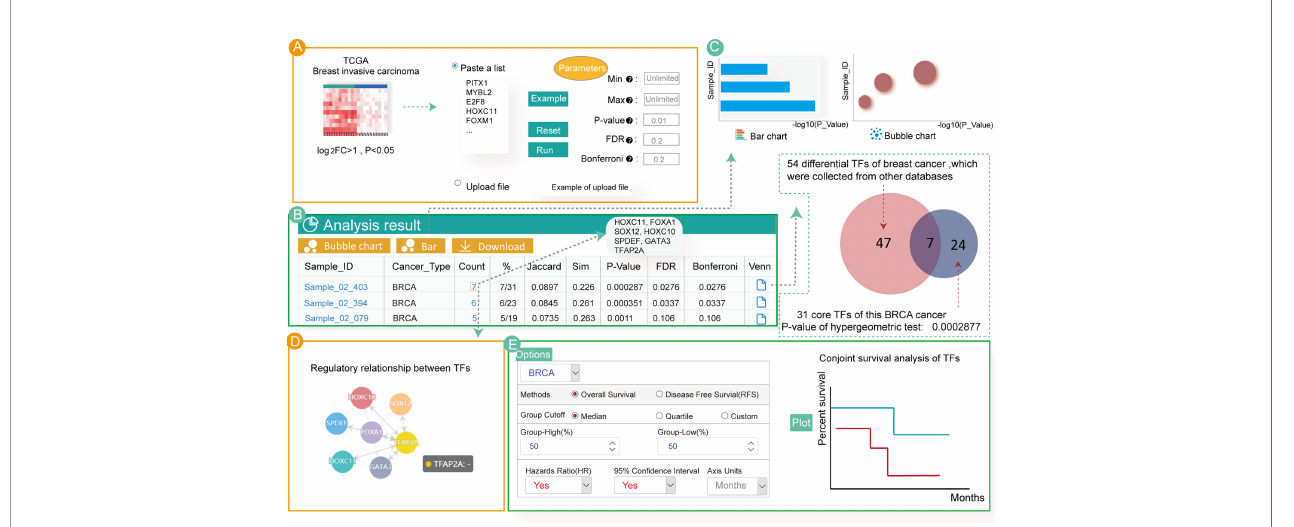
FIGURE 3 | Enrichment analyses associated with 54 up-regulated TFs in breast cancer. (A) Input and parameter selection for the enrichment analysis. (B) Results table for the enrichment analyses. (C) Visualization of the enrichment analysis results. (D) Regulatory relationship among the annotated TFs. (E) Conjoint survival analysis for the annotated